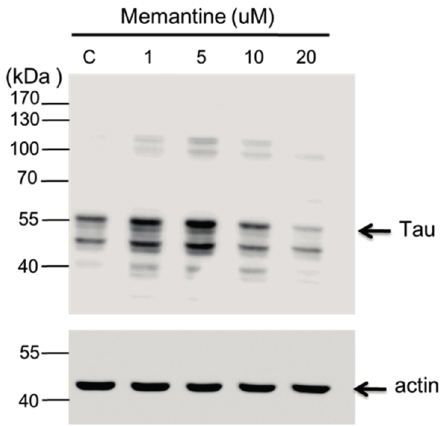
Figure 4. Western blot analysis showing the effect of memantine on tau protein expression in the N2A cell lysate. The neuroblastoma cells (~9 × 10 4 ) were treated with different concentrations of memantine (1, 5, 10 and 20 μ M). The PVDF membrane was exposed to anti-tau-1 (clone PC1C6) antibody to detect the endogenous tau protein from N2A cells. Each lane corresponds to the concentration (1–20 μ M) of memantine treatment; Lane C is for the untreated cell lysate. Tau protein is visible as bands between the 40 and 55 kDa regions. Molecular weight marker is shown left most. β -Actin was used as a loading control.